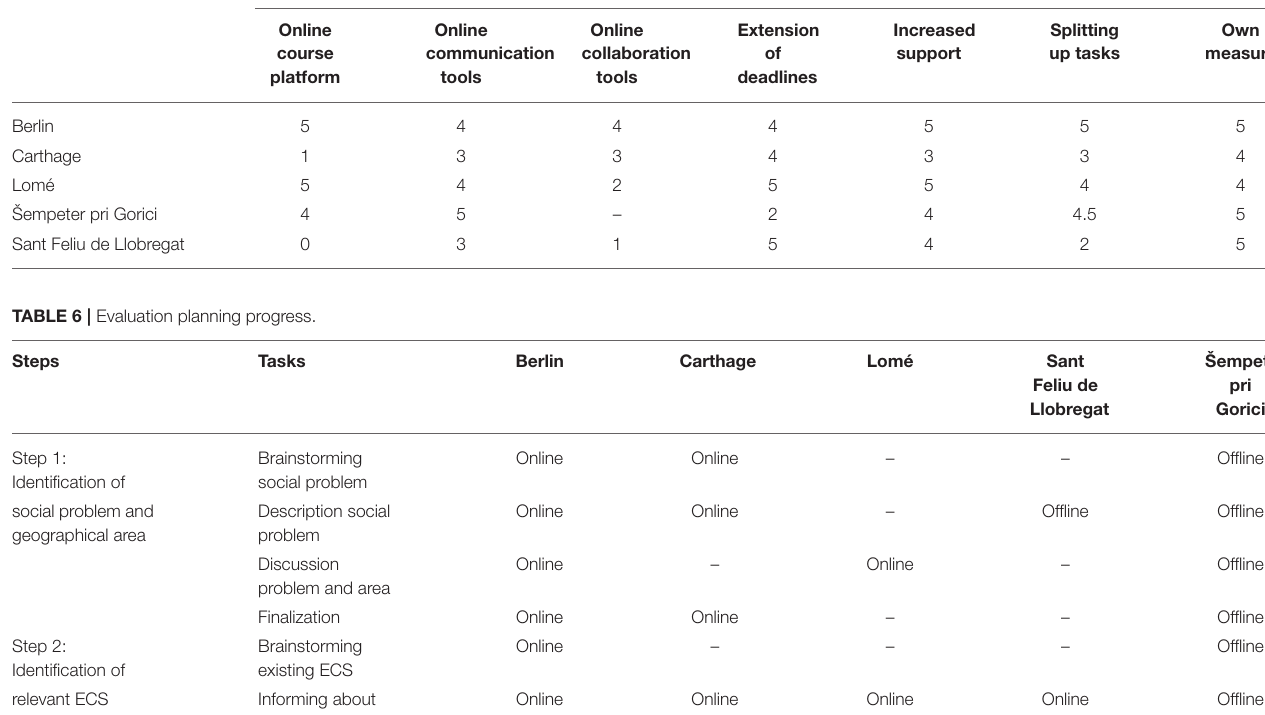
TABLE 5 | Evaluation of the usefulness of mitigation measures from 0 (not helpful) to 5 (very helpful). Cities